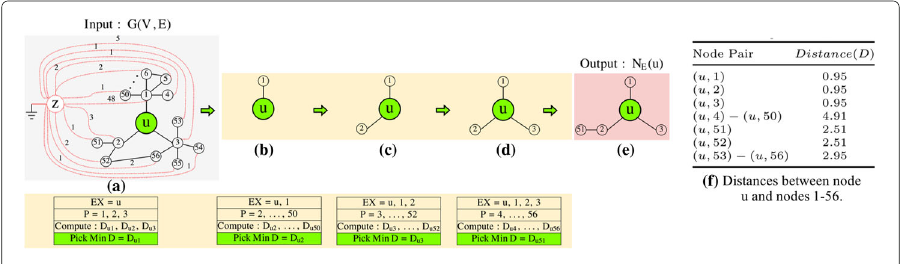
Fig. 2 Neighborhood expansion example. ( a ) Represents the entire graph, where node u is the node to expand. The number on each red-dotted line refers to an edge conductance. ( b, c, d ) and ( e ) Indicate the expansion of node u by adding its nearest neighbors: 1, 2, 3, and 51, respectively, to form the expanded neighborhood of node u , N E ( u ) . ( f ) Represents the computed distances between and its